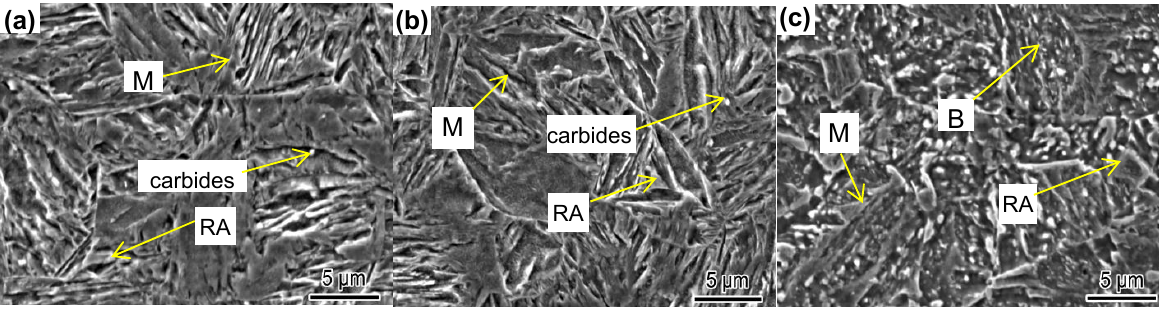
Figure 7. SEM of hot-formed samples in different positions: ( a ) top; ( b ) side; and ( c ) bottom.